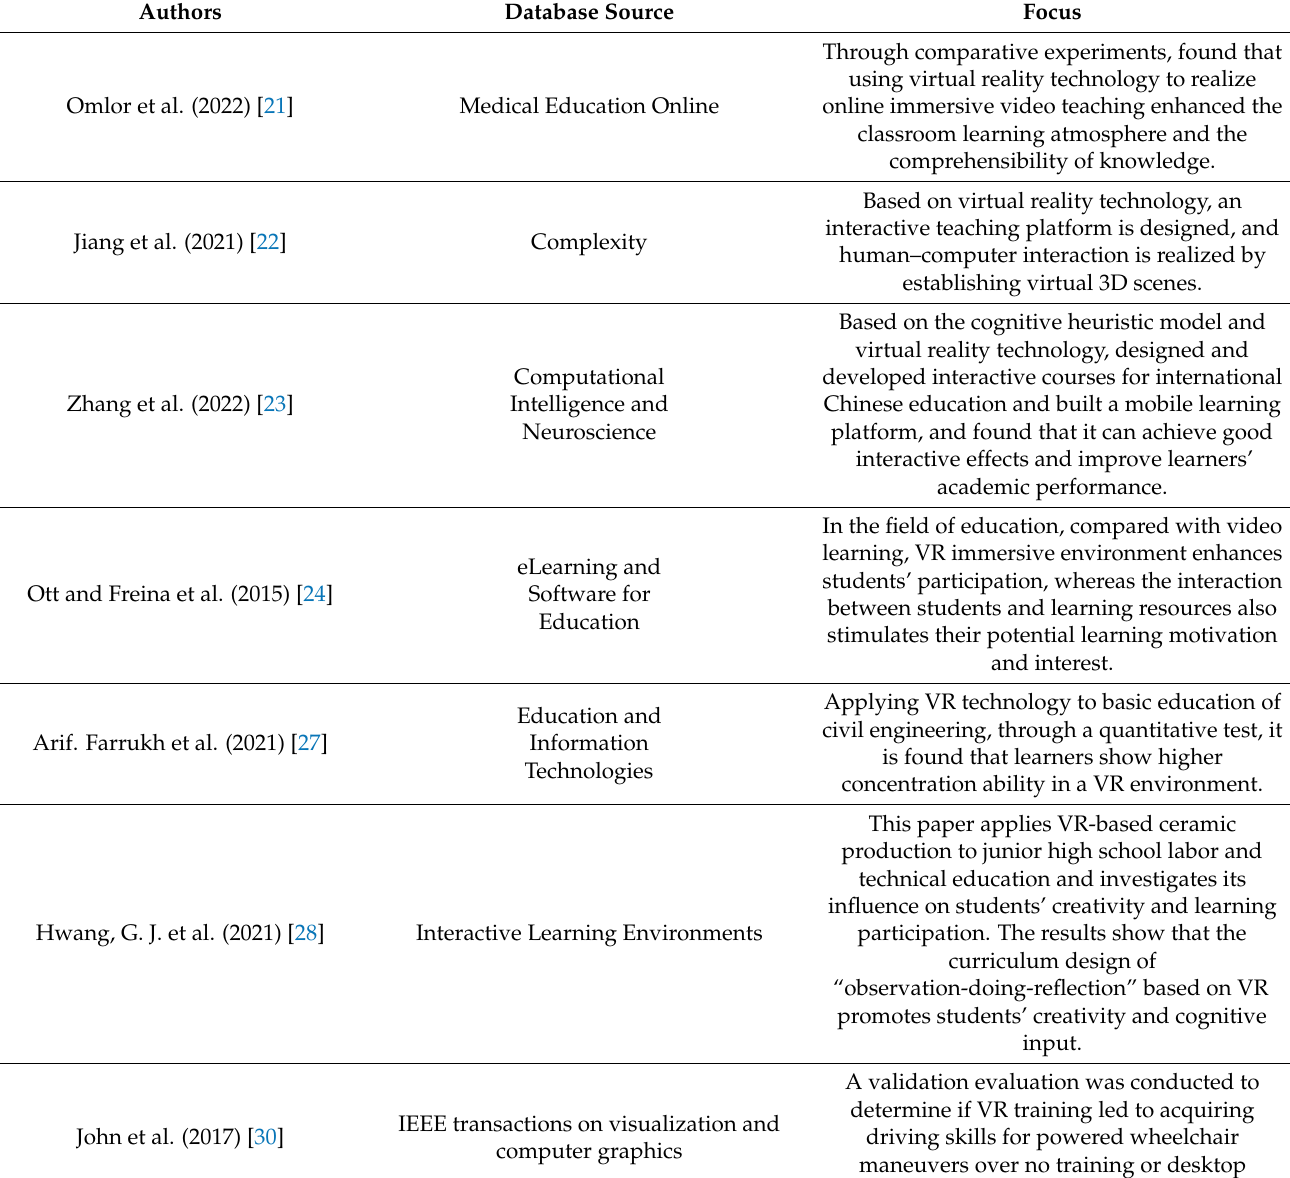
Table 2. Summary of the application of virtual reality systems in